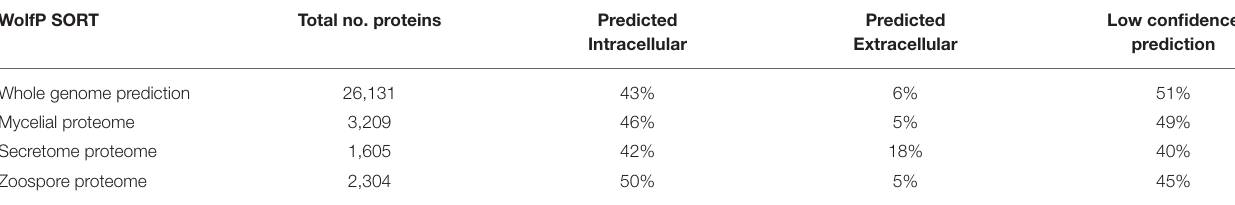
Predicted Low confidence Intracellular Extracellular prediction